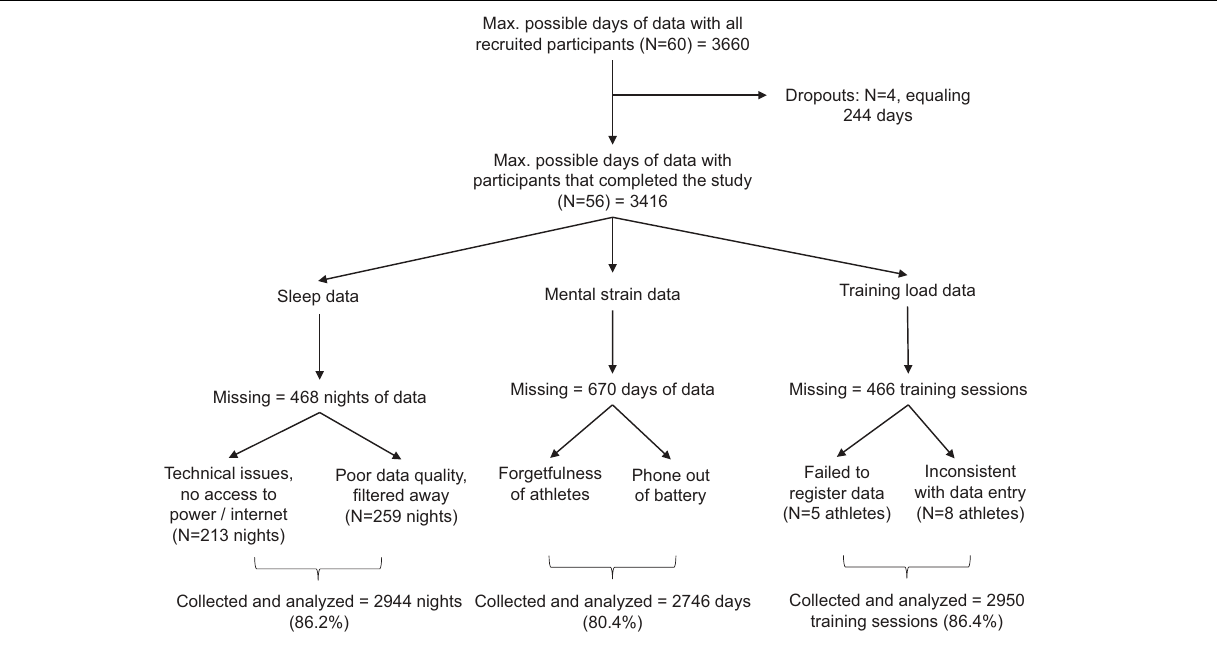
FIGURE 1 | A breakdown of data-collection compliance with reasons for missing data. Percentages were calculated out of 3416, the maximum number of observations in each of the daily measured variables with 56